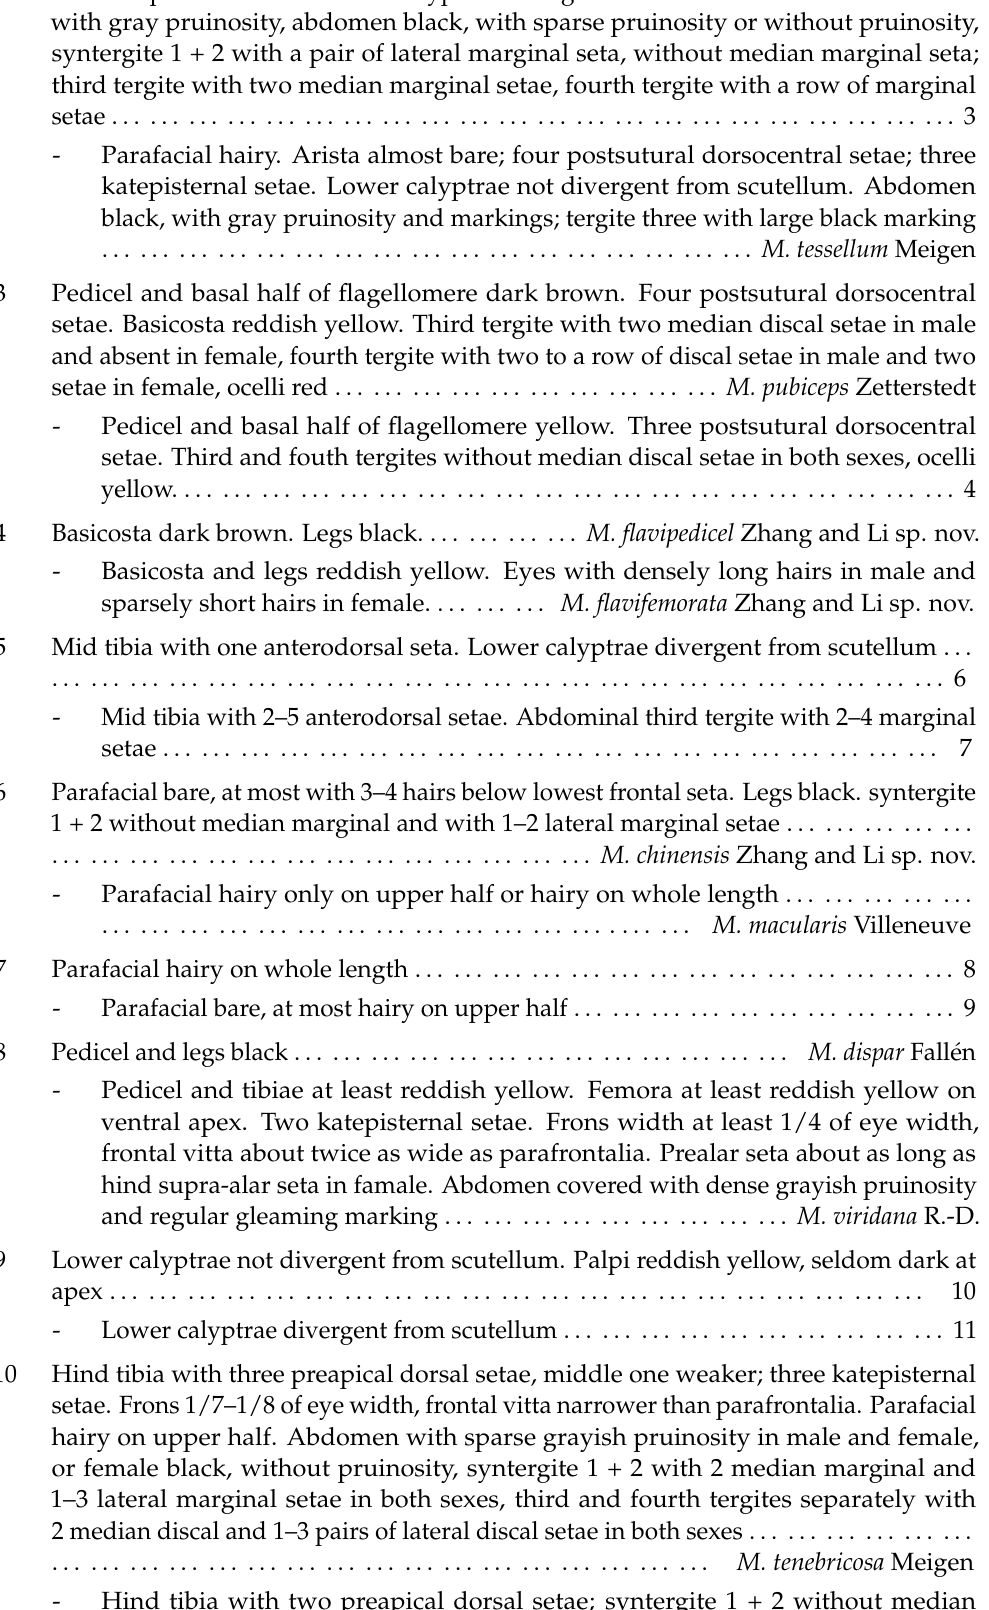
Two katepisternal setae. Lower calyptrae divergent from scutellum. Thoracic scutum with gray pruinosity, abdomen black, with sparse pruinosity or without pruinosity, syntergite 1 + 2 with a pair of lateral marginal seta, without median marginal seta; third tergite with two median marginal setae, fourth tergite with a row of marginal - Parafacial hairy. Arista almost bare; four postsutural dorsocentral setae; three katepisternal setae. Lower calyptrae not divergent from scutellum. Abdomen black, with gray pruinosity and markings; tergite three with large black marking 3 Pedicel and basal half of flagellomere dark brown. Four postsutural dorsocentral setae. Basicosta reddish yellow. Third tergite with two median discal setae in male and absent in female, fourth tergite with two to a row of discal setae in male and two setae in female, ocelli red . . . . . . . . . . . . . . . . . . . . . . . . . . . . . . M. pubiceps Zetterstedt - Pedicel and basal half of flagellomere yellow. Three postsutural dorsocentral setae. Third and fouth tergites without median discal setae in both sexes, ocelli